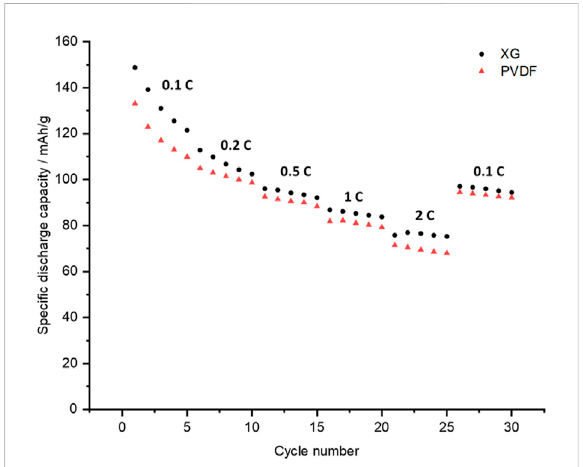
FIGURE 7 Rate capability of P3-NNM when using xanthum gum (black circles) or PVDF (red triangles) as the binder. Cells are cycled galvanostatically between 2.0 and 4.5